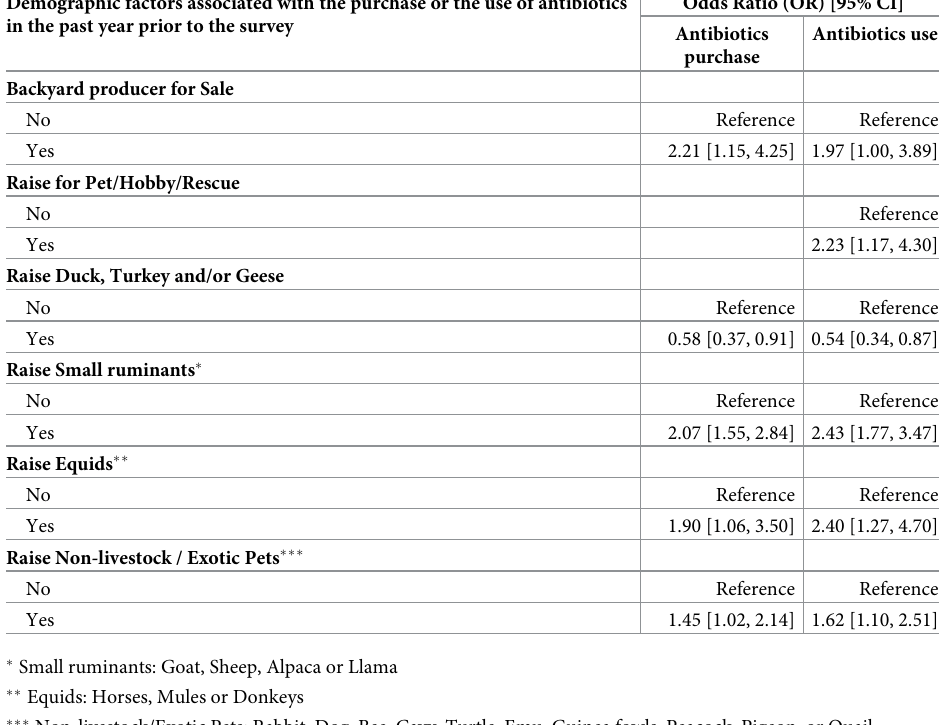
Table 4. Results of the multivariable logistic regression models about antibiotics purchase and use in the past year prior to the survey. Demographic factors associated with the purchase or the use of antibiotics in the past year prior to the survey